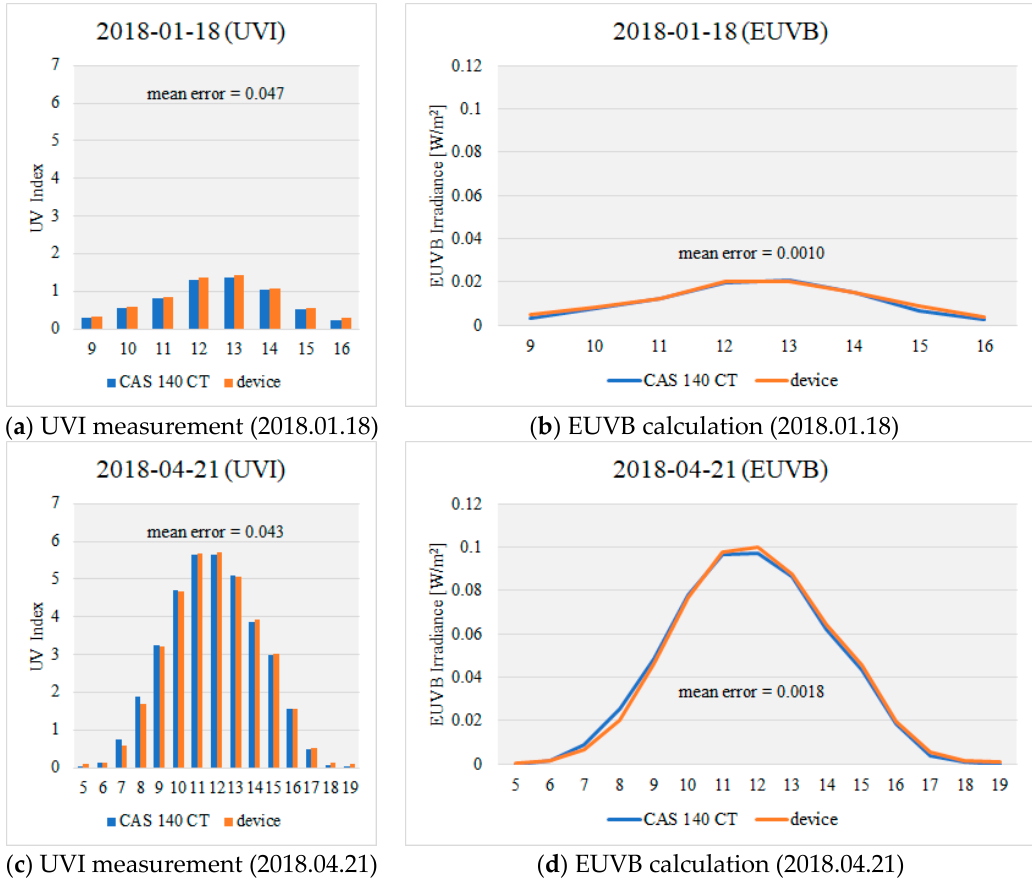
Figure 9. Graphs of the measurement results .